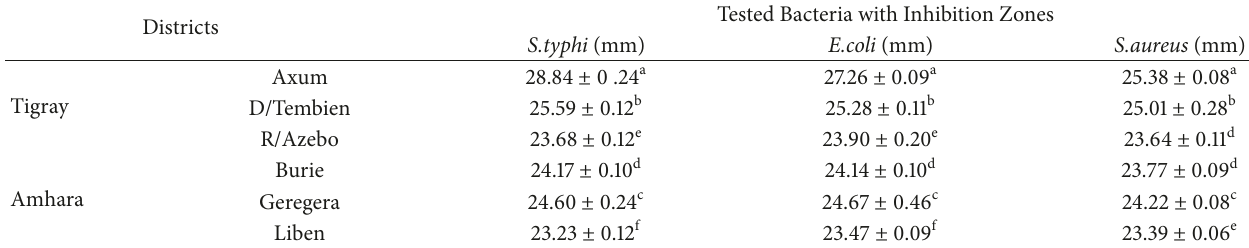
Table 5: Antibacterial potential of the tested honey samples against selected bacterial